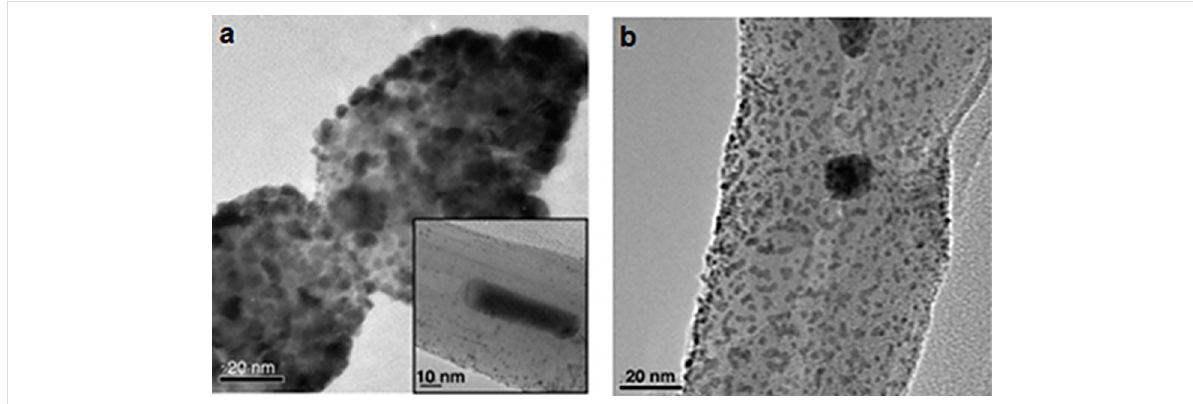
Figure 14: HRTEM images of (a) Pt-NPs-covered CNT tip; inset shows individual particles on the ends of CNTs. (b) individual NPs and clusters along the middle length of the CNT. Adapted with permission from [121]. Copyright 2010 Elsevier.